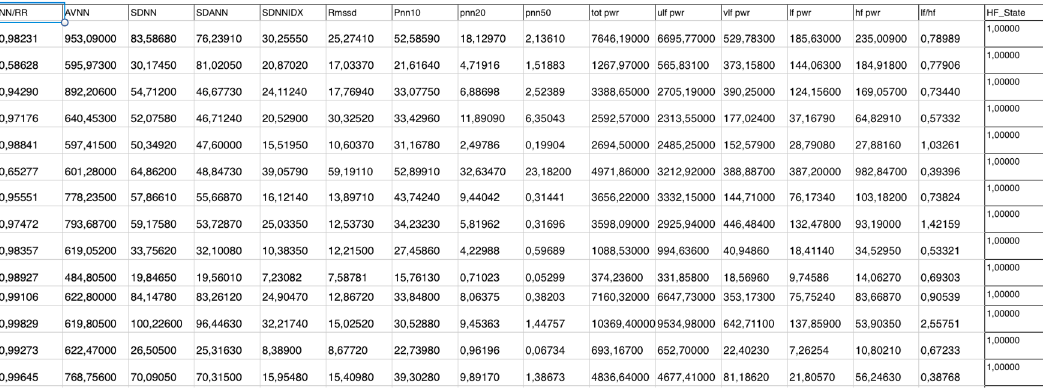
Figure 5. Abstract of current dataset in suitable format for analysis.